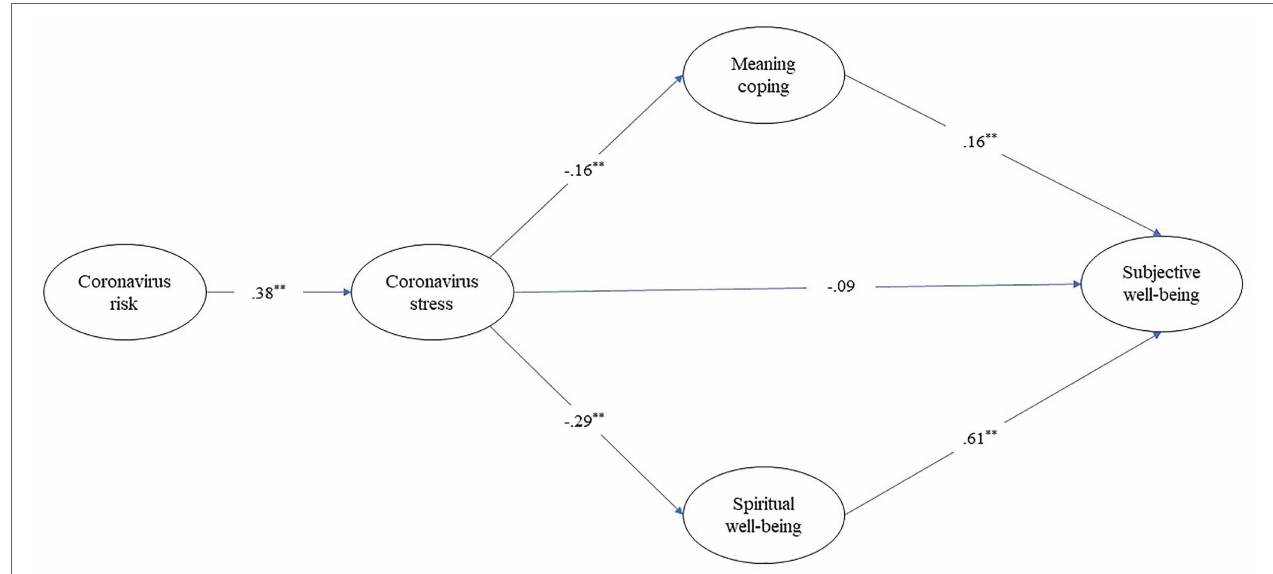
FIGURE 1 | Mediation analysis of associations between the variables of the study. ** p <